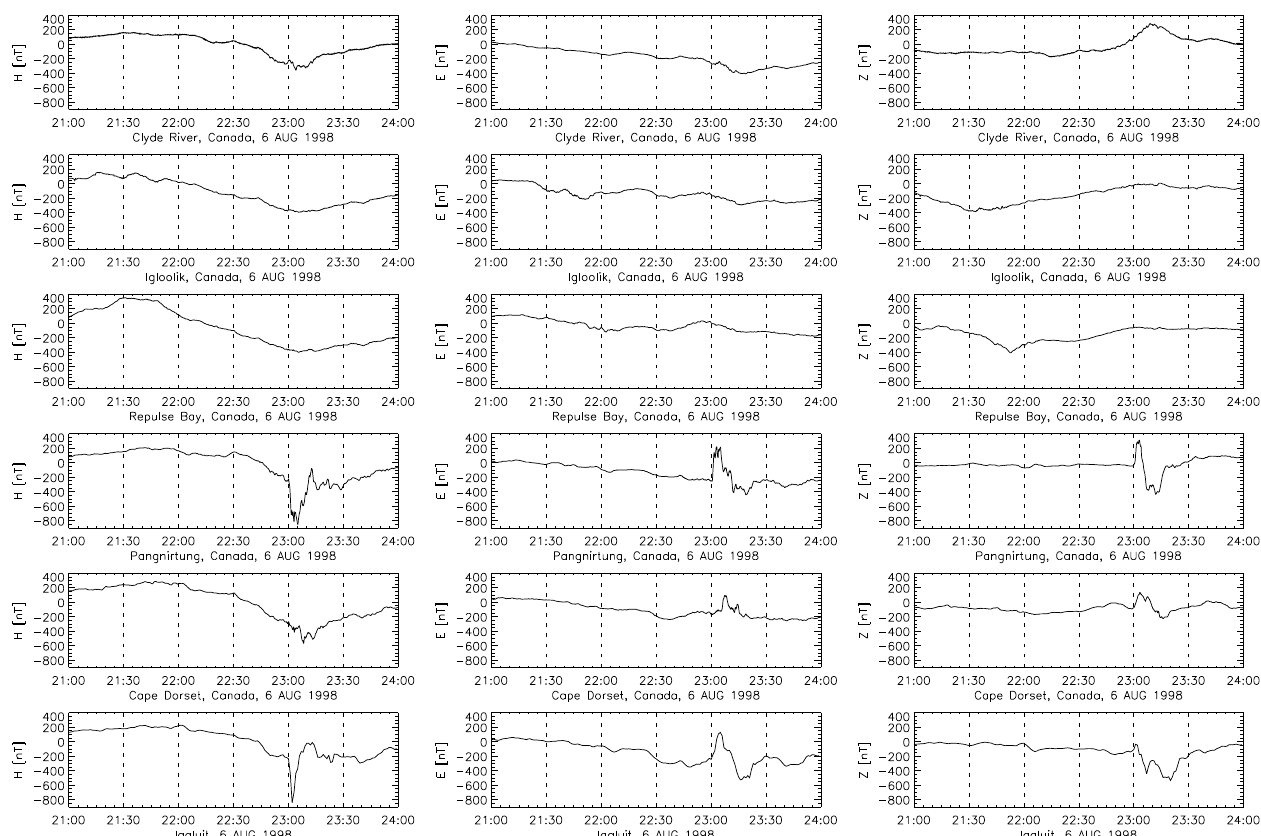
Fig. 7. Magnetometer data from six stations in arctic Canada. The data are normalized by a quiet day mean. Time is UT. Left: CGM northward horizontal component (H). Middle: CGM eastward horizontal component (E). Right: vertically downward component (Z). The plots are arranged by geomagnetic latitude so that the top panels show data from the station furthest poleward. The time resolution is one minute for Iqaluit and five seconds for the five MACCS stations. Coordinates for the stations are given in Table 1.